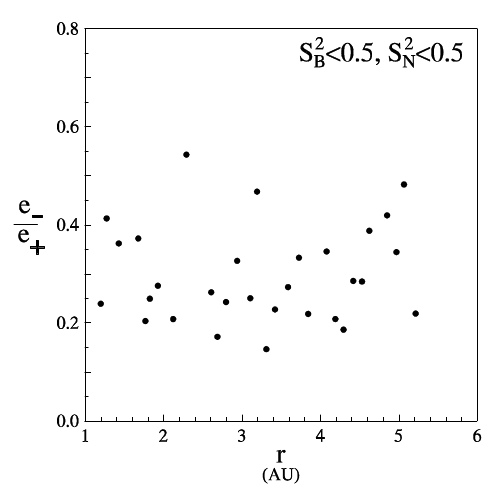
Figure 46: Ratio of e – over e + within fast wind between 1 and 5 AU as observed by Ulysses in the ecliptic. Image reproduced by permission from Bavassano et al. (2001), copyright by AGU.